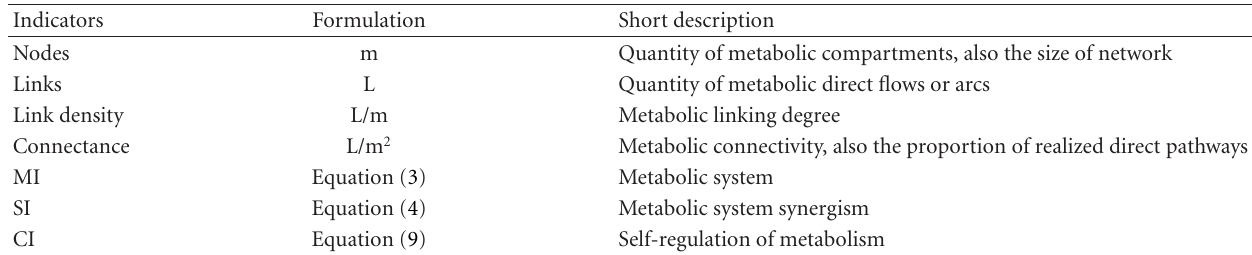
Table 1: System-wide indicators of metabolism model.